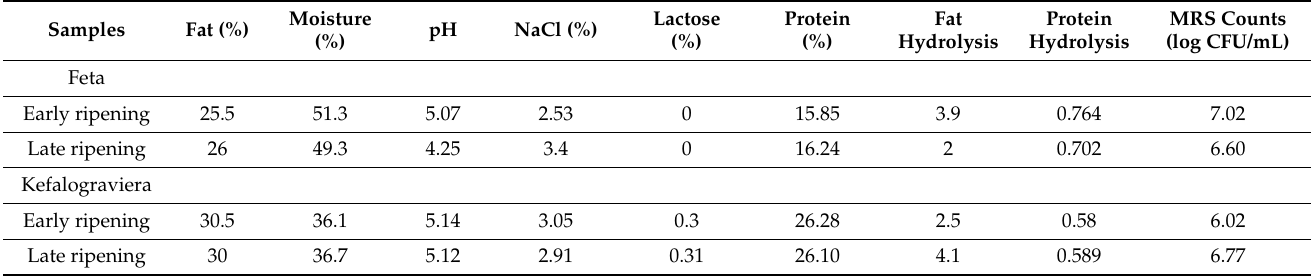
Table 1. Physicochemical and microbiological characteristics of Feta and Kefalograviera cheeses in early and late